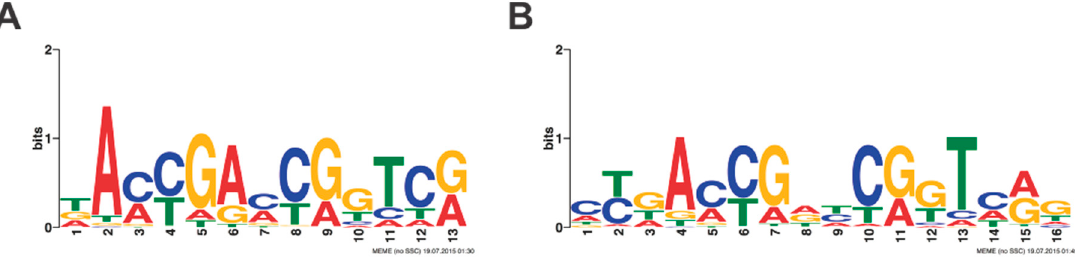
Figure 2. TTHB023 consensus sequences. Multiple Em for Motif Elicitation (MEME) software was used with 1000 Round 6 DNA sequences and either ( A ) no filters or ( B ) with a palindromic filter.